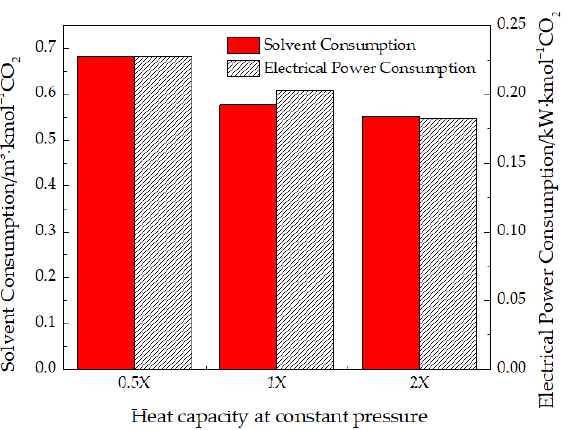
Figure 5. The influence of heat capacity at a constant pressure of [emim][Tf 2 N] on the volume of solvent circulation and energy consumption. The red areas represent solvent consumption and the shaded areas represent electrical power consumption.